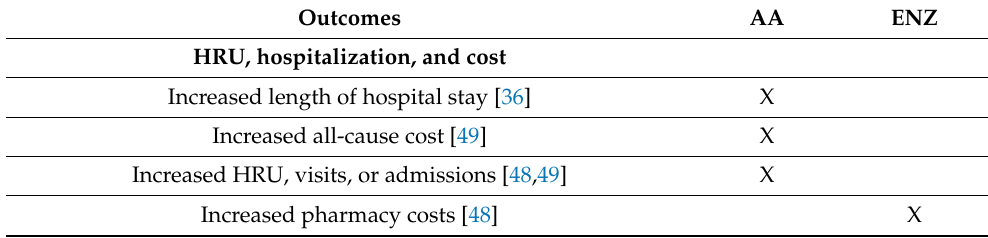
Table 3. Cont. Outcomes AA ENZ HRU, hospitalization, and cost Increased length of hospital stay [36] X Increased all-cause cost [49] X Increased HRU, visits, or admissions [48,49] X Increased pharmacy costs [48]